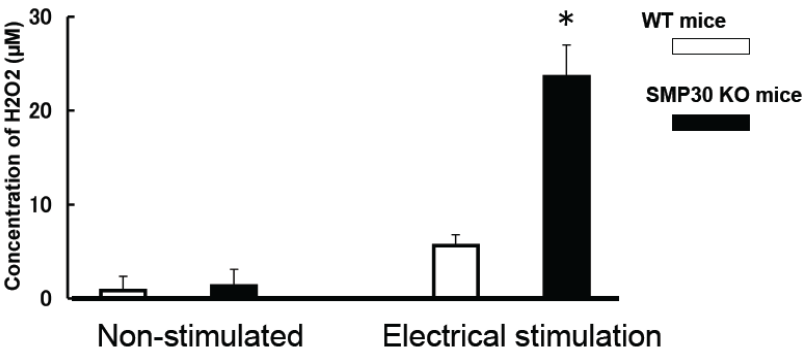
Figure 4. The level of H the cardiac myocyte supernatant increased with pacing. H higher than in WT cardiac myocytes. Values are expressed as the mean ± S.E.M. * p < 0.01 vs. WT mice ( n = 12